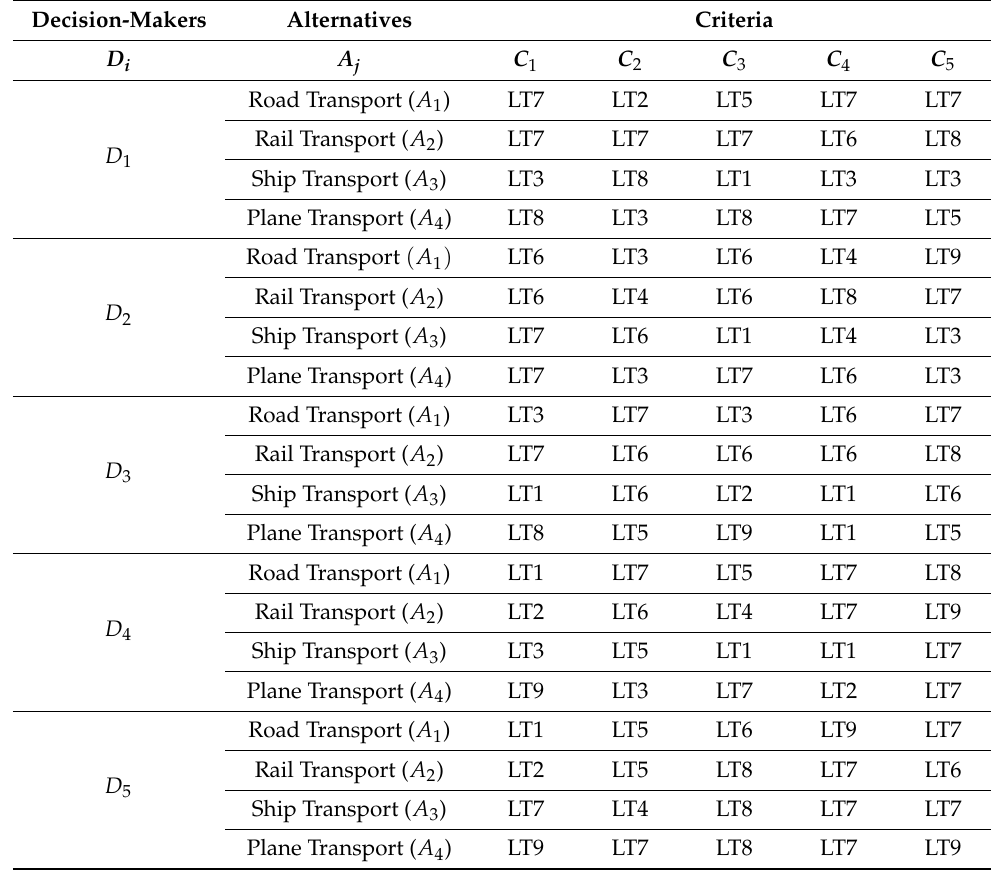
Table 3. Economic factors preference performance matrix in linguistic terms, based on decision-maker